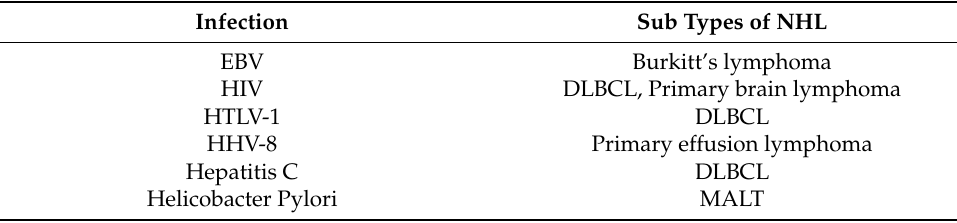
Table 2 below indicates subtypes of NHL associated with various infections. Table 2. Subtypes of non-Hodgkin’s lymphoma (NHL) associated with